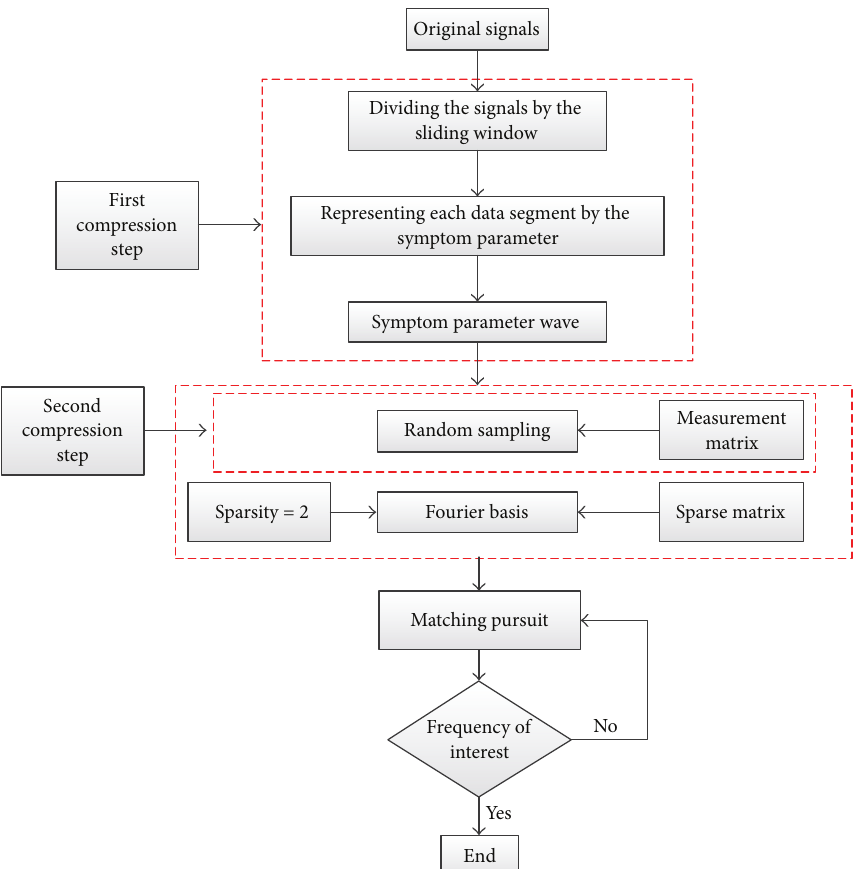
Figure 2: Flow diagram of the compressed fault detection